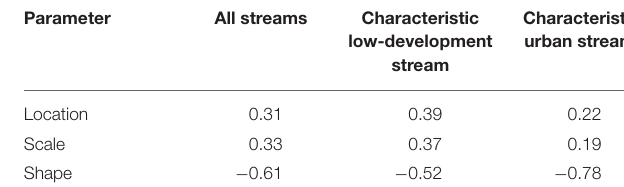
TABLE 4 | Parameters used in the Generalized Extreme Value (GEV) distributions for characteristics streamflow distributions based on the median values for all